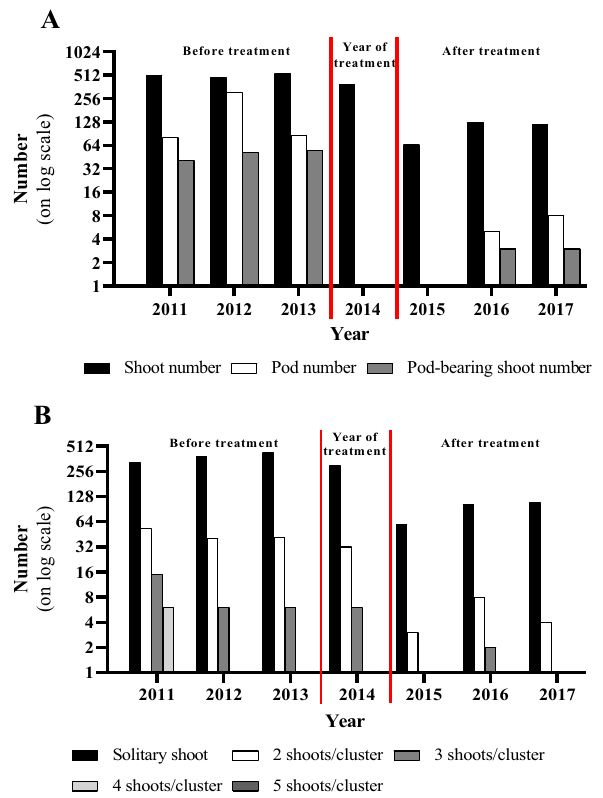
Figure 2. ( A ) Changes in the numbers of shoots, pod-bearing shoots, and pods ( B ) numbers of solitary and clustering milkweed